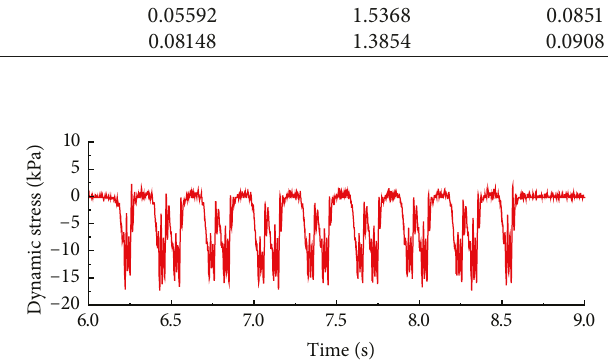
Figure 12: Measured time history of vertical dynamic stress (330 km/h).